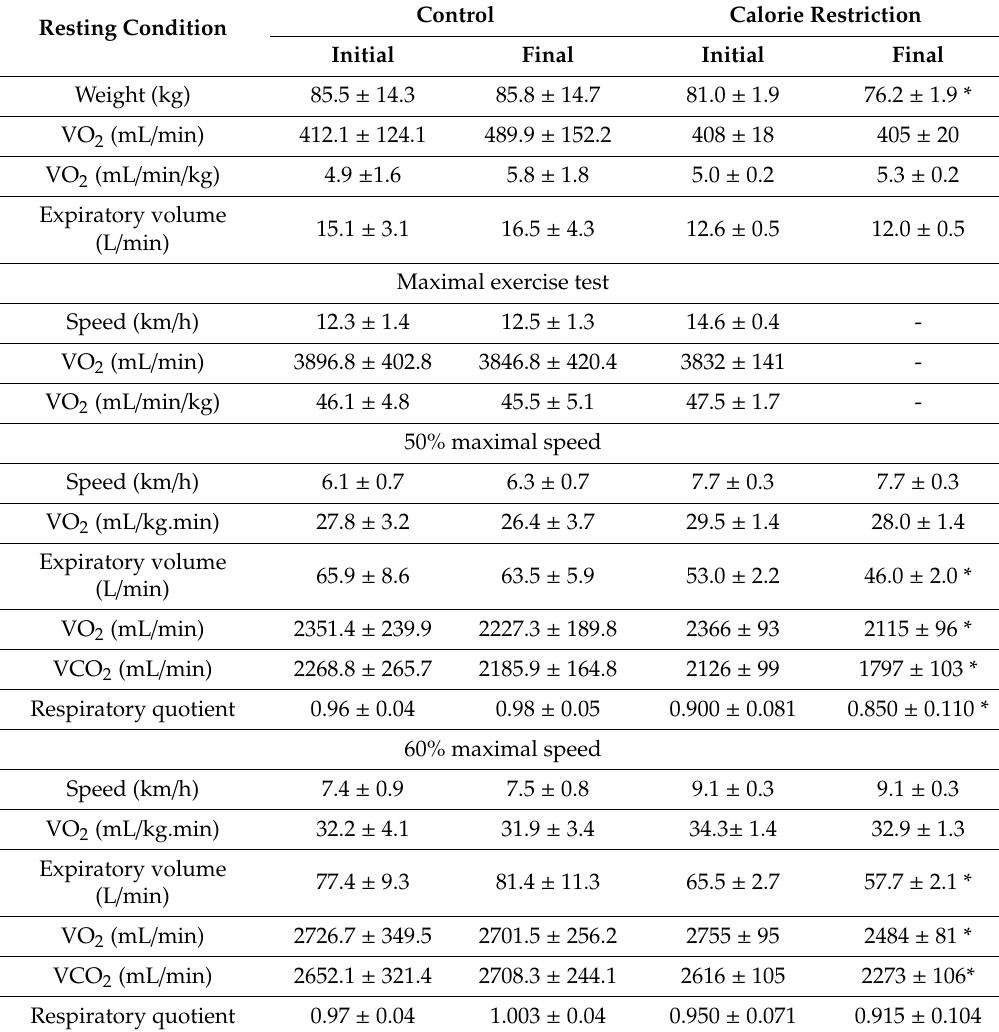
Table 3. Performance parameters of the participants in the exercise energy e ffi ciency tests. Resting